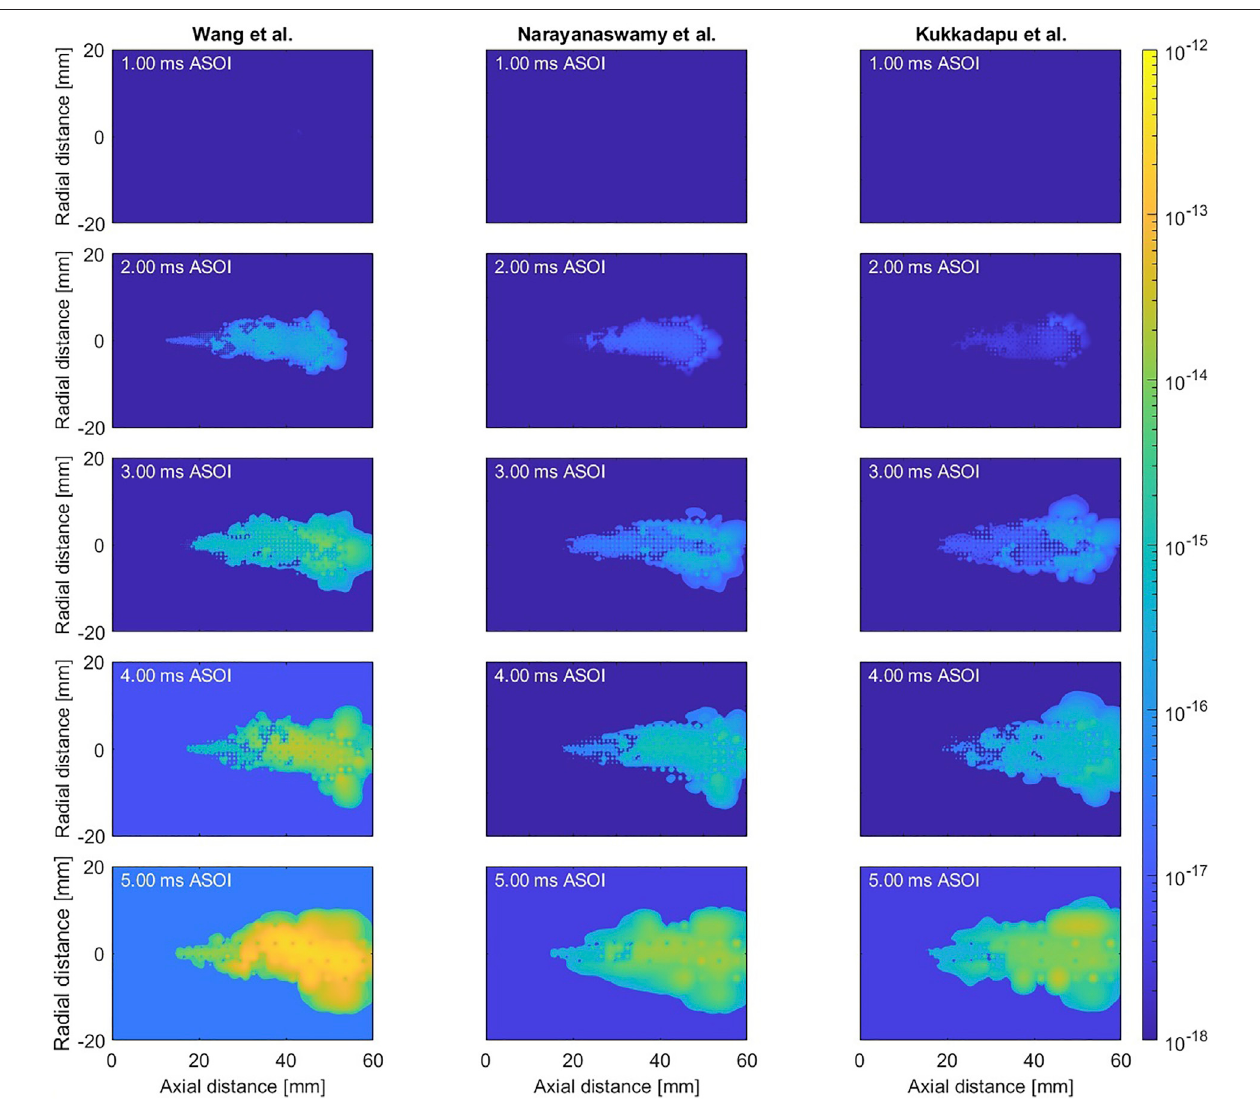
FIGURE 3 | Projections of soot mass [kg-m] at select timings after the start of injection for simulations using the three mechanisms with the PSM soot model.